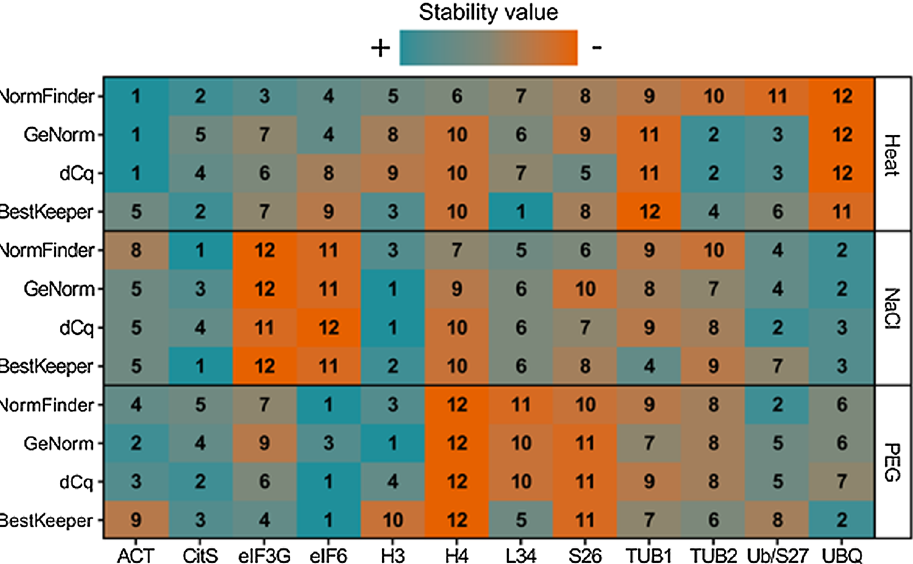
Figure 2. Expression stability and ranking of candidate reference genes for each algorithm, NormFinder, GeNorm, dCq, BestKeeper and in response to heat shock 10 min at 45 °C then 20 °C, salt stress at 500 mM NaCl and 15 and 30% (w/v) PEG-induced dehydration stress. The numbers corresponding to the rank of each candidate were calculated from the SV, M, mSD, CV values for NormFinder, GeNorm, dCq and BestKeeper, respectively.